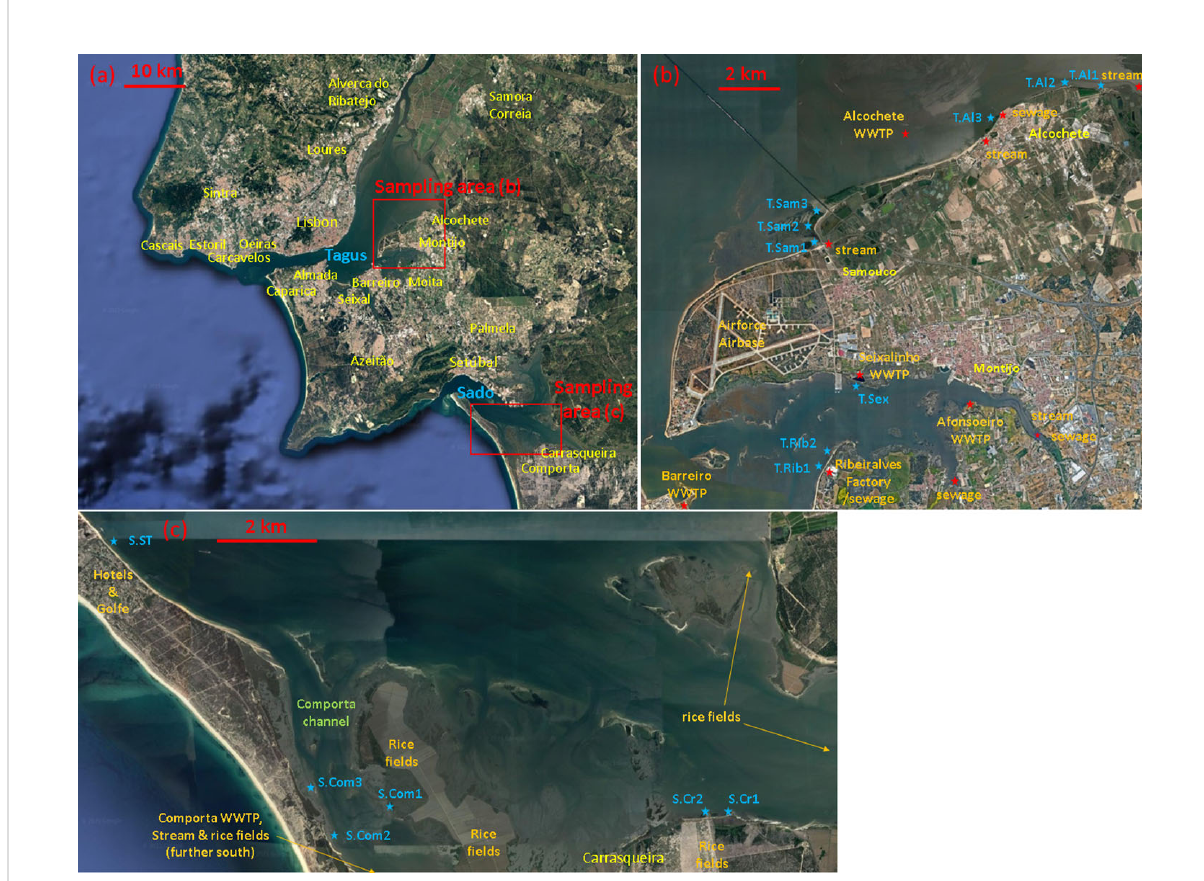
FIGURE 1 Region of study with the Tagus and Sado estuaries, urban areas, locations of sampling sites, and anthropogenic sources of nutrient enrichment. Aerial photos obtained from Google Maps. (A) Lisbon and Setubal metropolitan areas with Tagus and Sado estuaries, (B) sampling locations in the Tagus estuary, and (C) sampling locations in the Sado